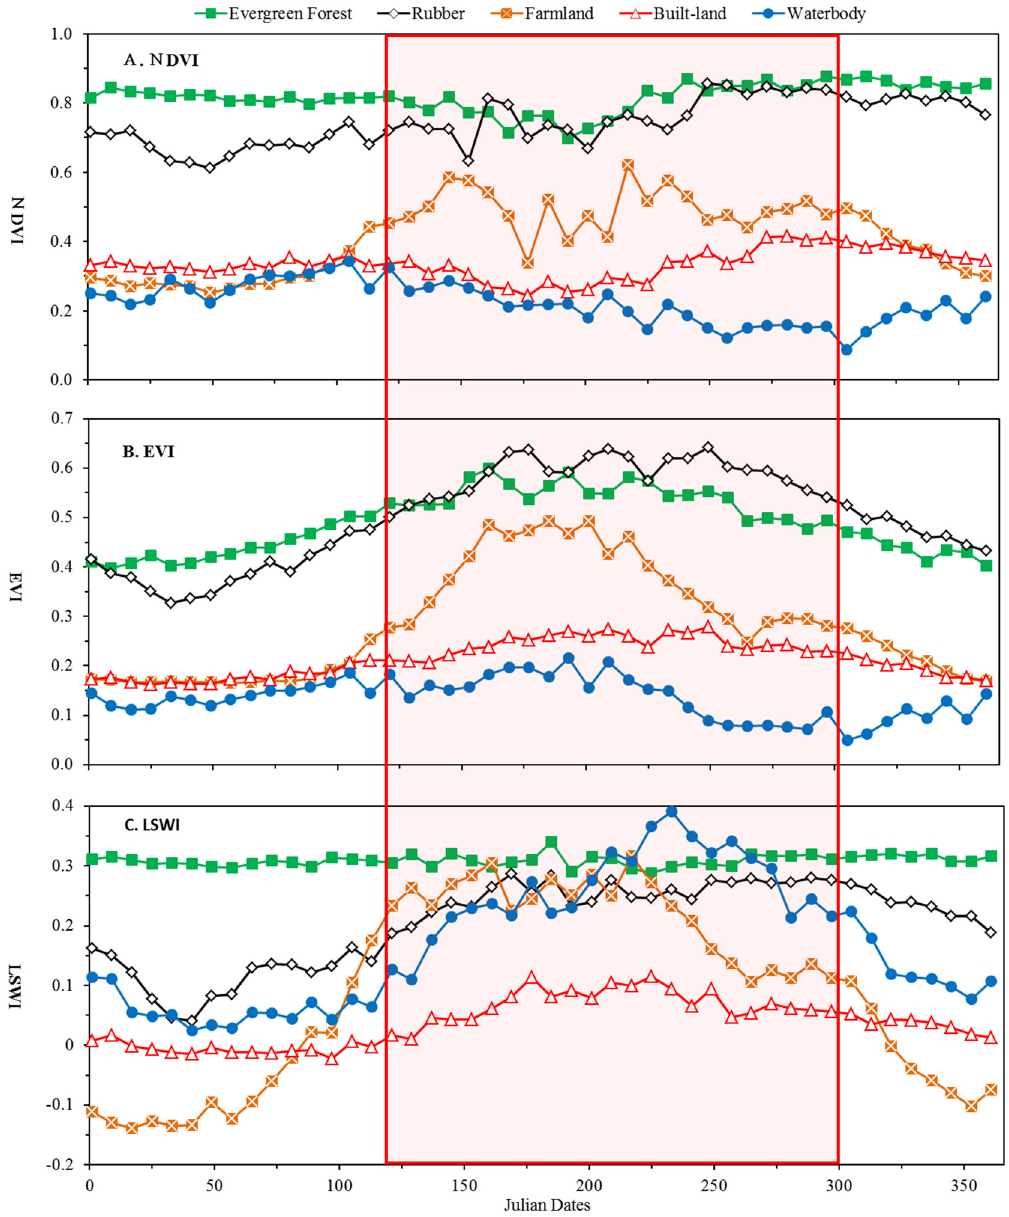
Figure 3. MODIS annual time-series analyses for different land cover types of the study area. Normalized Difference Vegetation Index (NDVI), Enhanced Vegetation Index (EVI), and Land Surface Water Index (LSWI) annual time series of five typical land cover types (evergreen forests, rubber plantations, farmlands, built-lands, and water bodies) were created from MODIS MOD09A1 between 2006 and 2014. Annual time-series profiles of NDVI ( A ); EVI ( B ); and LSWI ( C ) are separately analyzed to capture change information and rules of different land cover types of the study area. The area covered by red rectangle is the rainy season about from Julian Date 120 to 350 and the rest of the area represents the dry season in the study area.